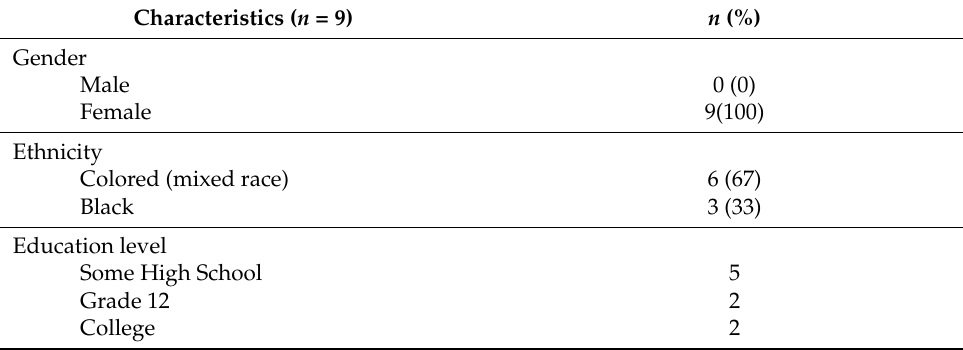
Table 1. Participant Socio-demographic